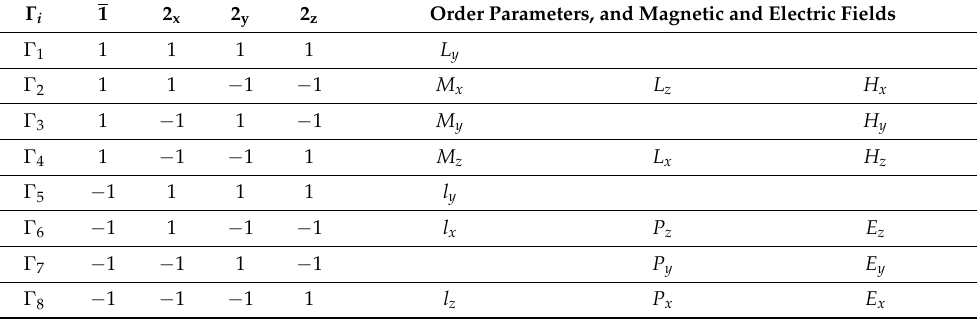
Table 1. Irreducible representations of the Pbnm symmetry group.